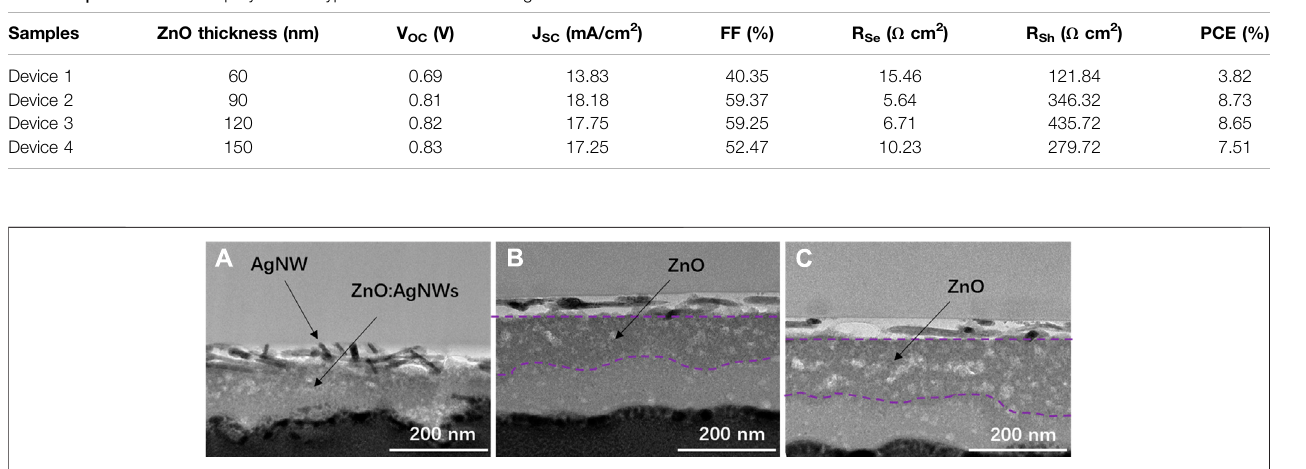
Frontiers in Chemistry |